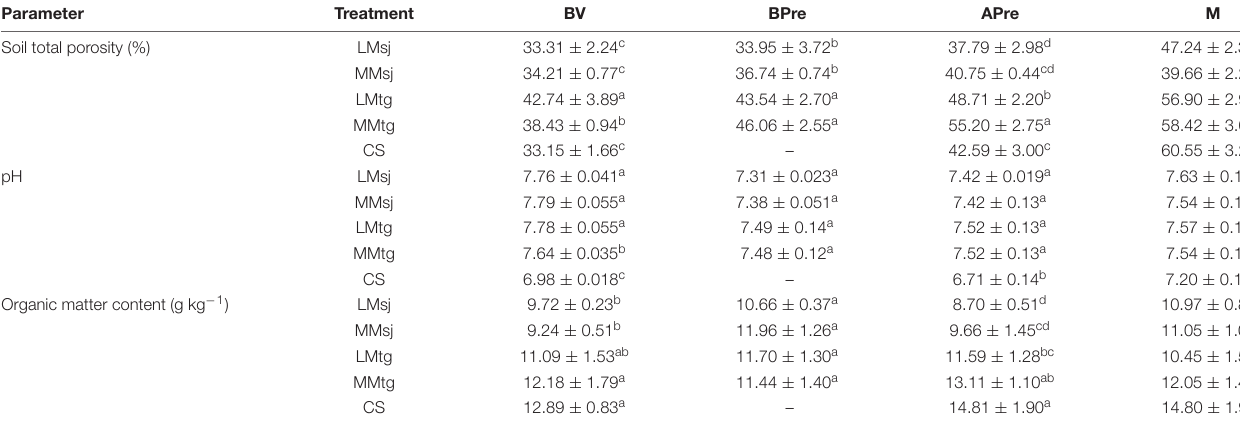
TABLE 3 | Concentration of physicochemical parameters in topsoil (0–40 cm).